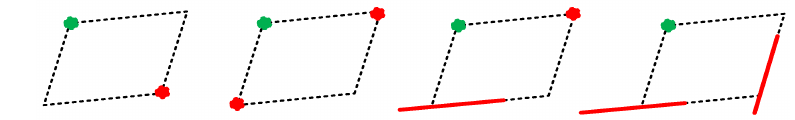
Figure 5. Criteria of parallel grid